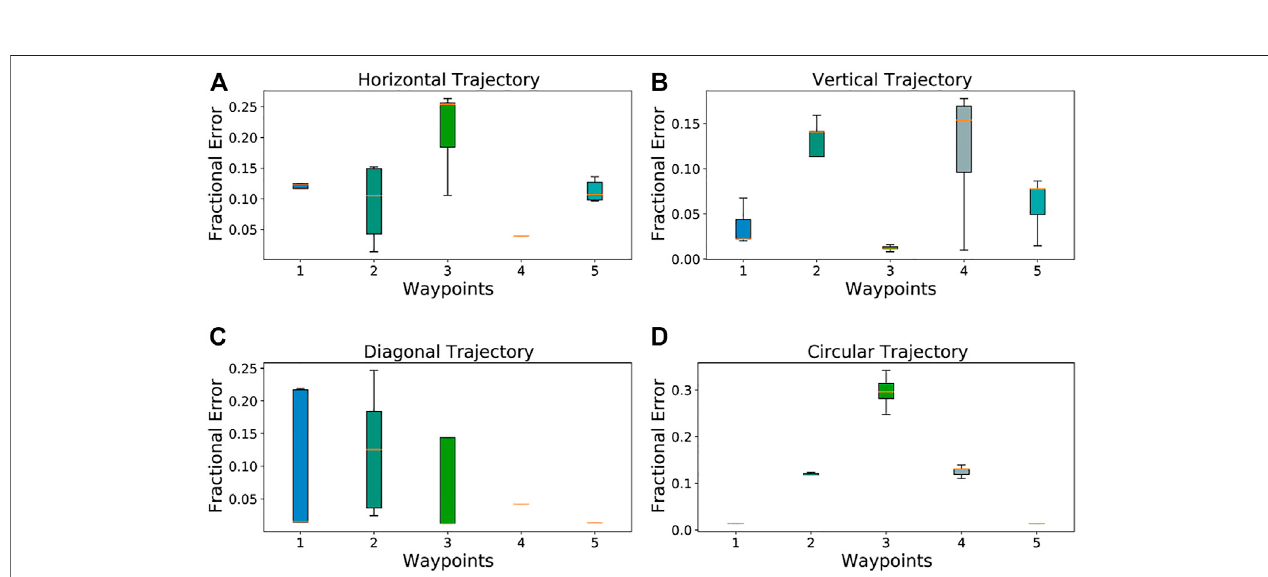
FIGURE 7 | Touch Tracking Error Plots. The middle bar represents the median error, the width of each bar is the Interquartile Range, and the fence widths are 1.5 ×IQR. (A) Average Deviation for Vertical Trajectory, (B) Average Deviation for Horizontal Trajectory, (C) Average Deviation for Diagonal Trajectory, (D) Average Deviation for Circular